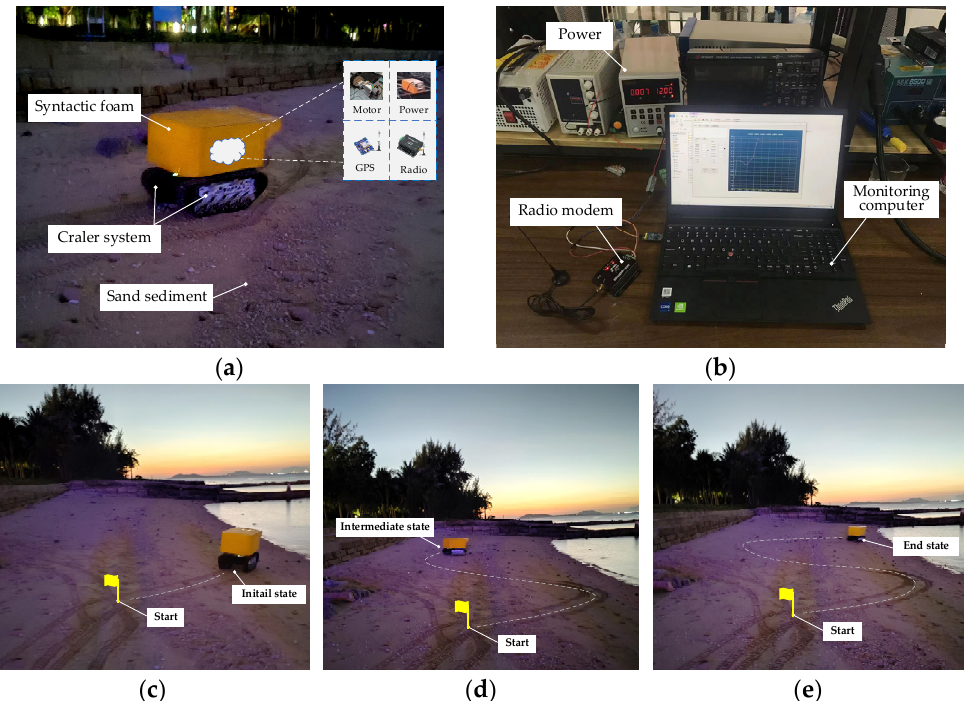
Figure 13. Scaled test prototype and the testing scenes. ( a ) 2:1 scaled test prototype and main components; ( b ) remote monitoring terminal; ( c ) initial motion state; ( d ) intermediate motion state; ( e ) ending motion state.